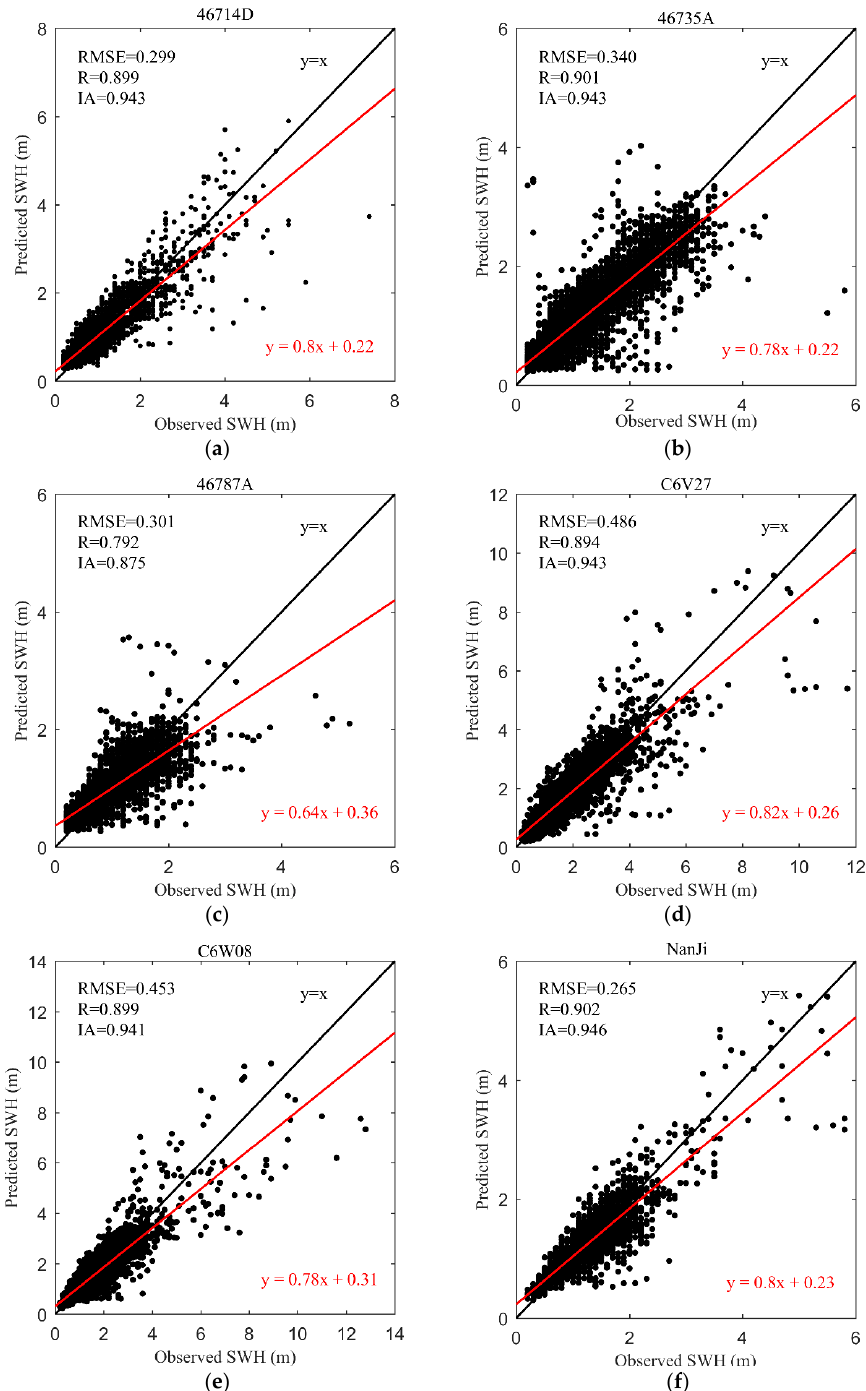
Figure 5. Scatter diagram for 6 hourly forecasting based on GRU at various stations: (a) station 46714D, (b) station 46735A, (c) station 46787A, (d) station C6V27, (e) station C6W08, (f) station NanJi. 46714D, ( b ) station 46735A, ( c ) station 46787A, ( d ) station C6V27, ( e ) station C6W08, ( f ) station